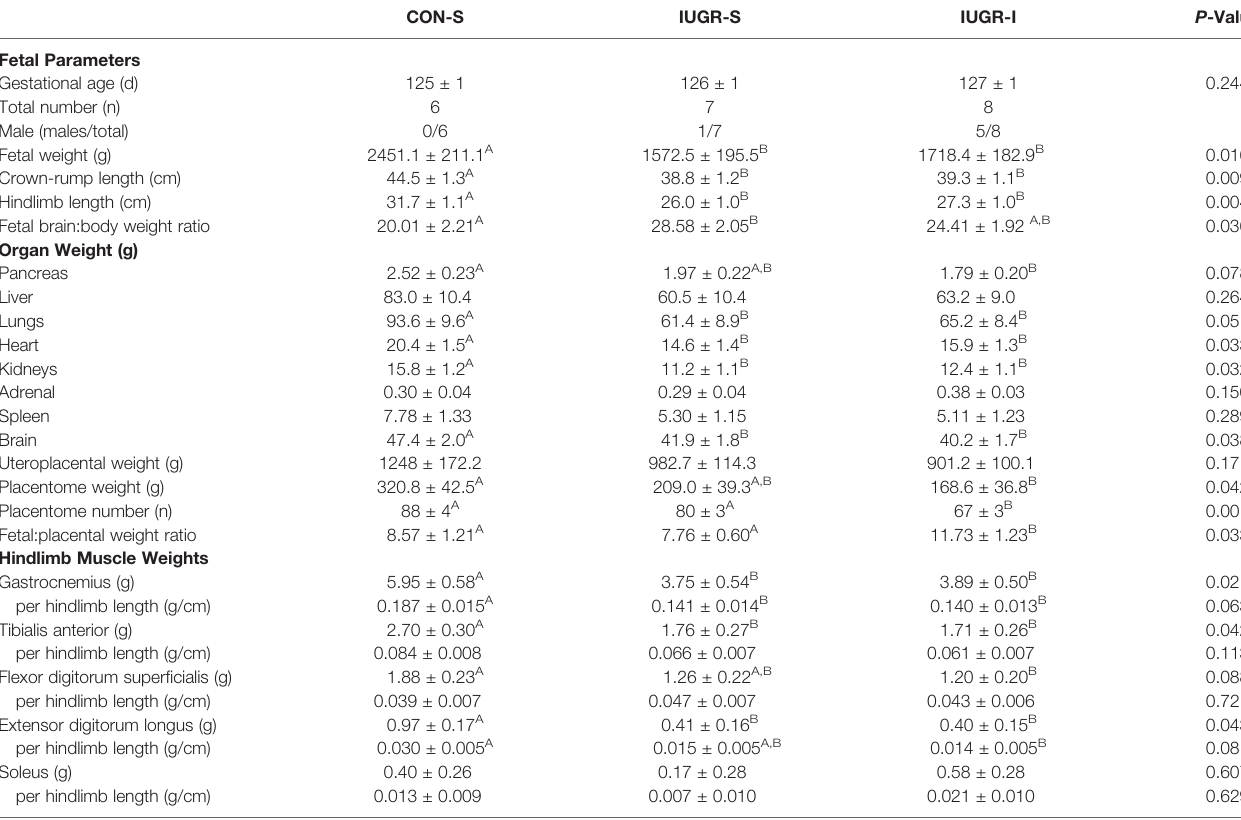
TABLE 2 | Fetal weight and length measurements at the end of the infusion